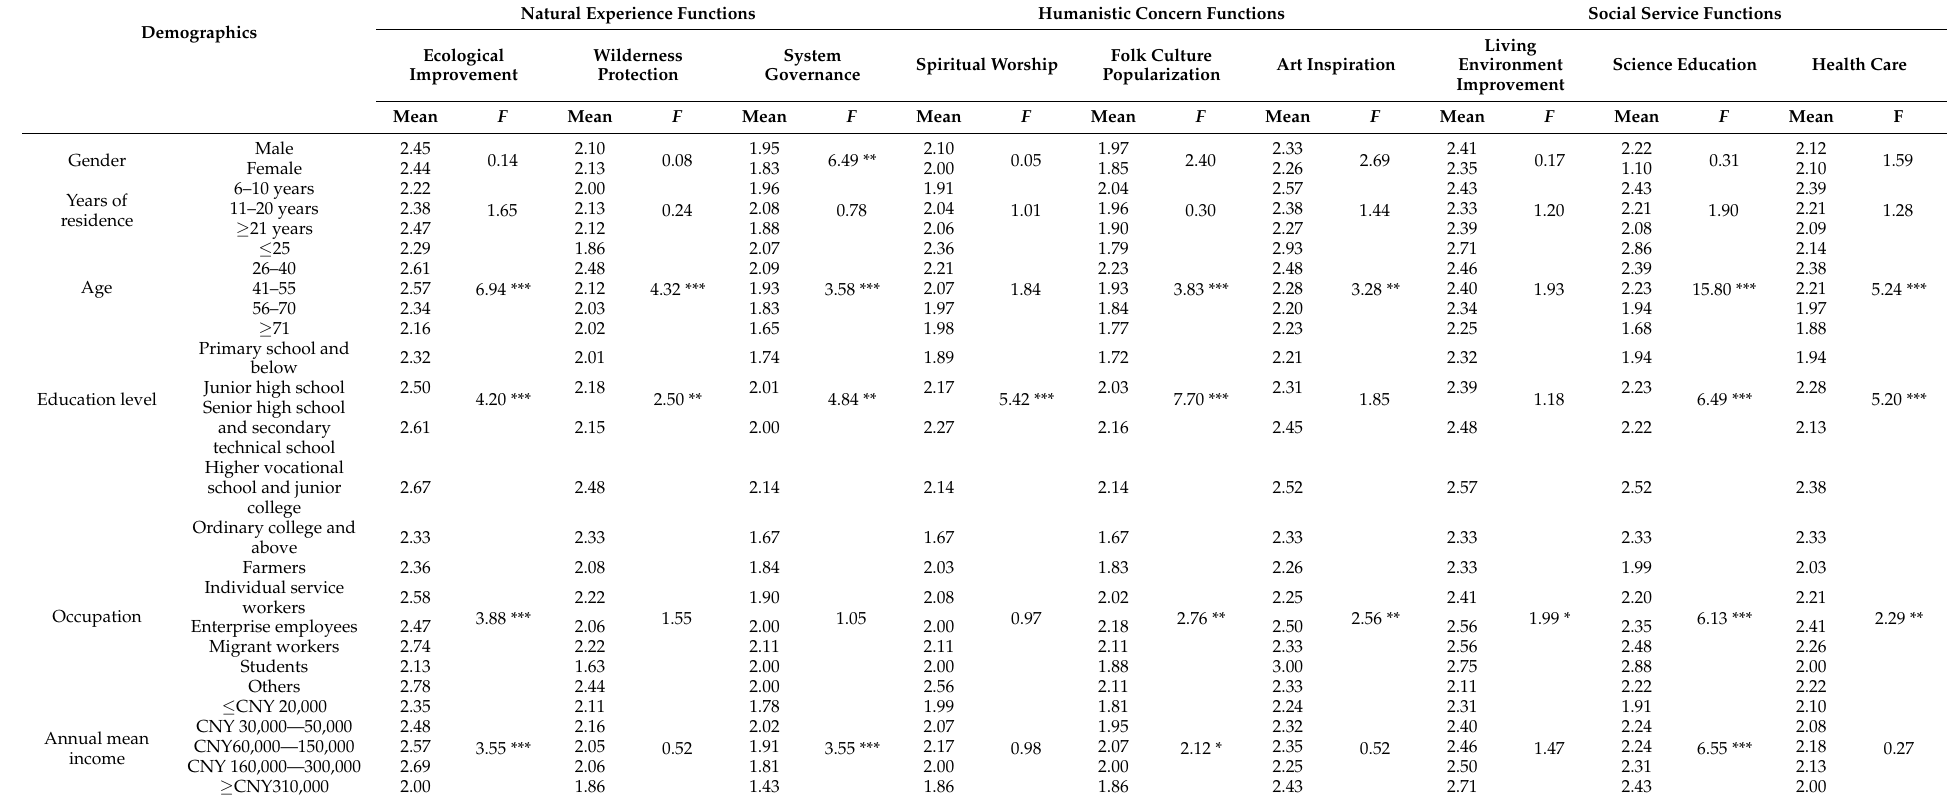
Table 5. Influence of demographics on the cognition of cultural ecosystem